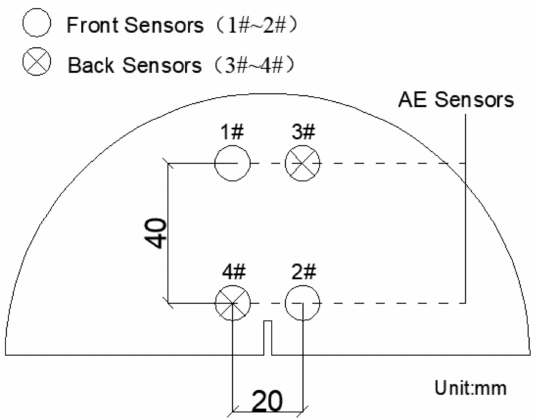
Figure 5. Layout of sensors.